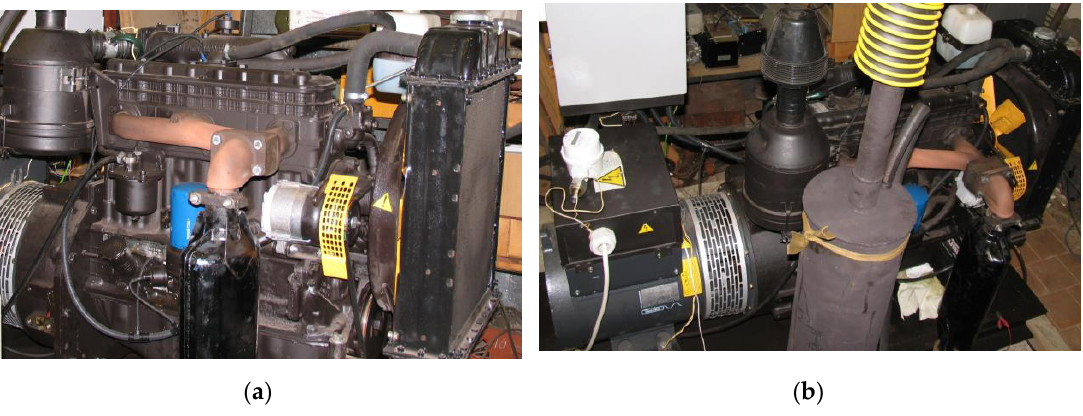
Figure 1. D-243 diesel engine ( a ) and diesel-generator set ( b ).